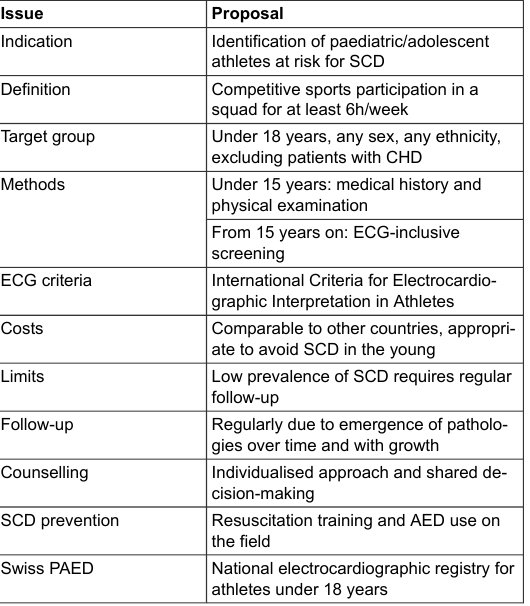
Table 4: Overview of proposals for preparticipation evaluation in Swiss paedi- atric and adolescent athletes.